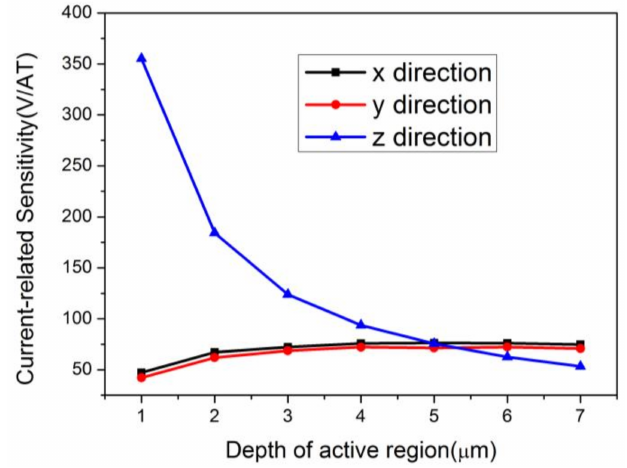
Figure 14. Relationships between the current-related sensitivities in three directions and the active region’s depth. The depth changes from 1 µ m to 7 µ